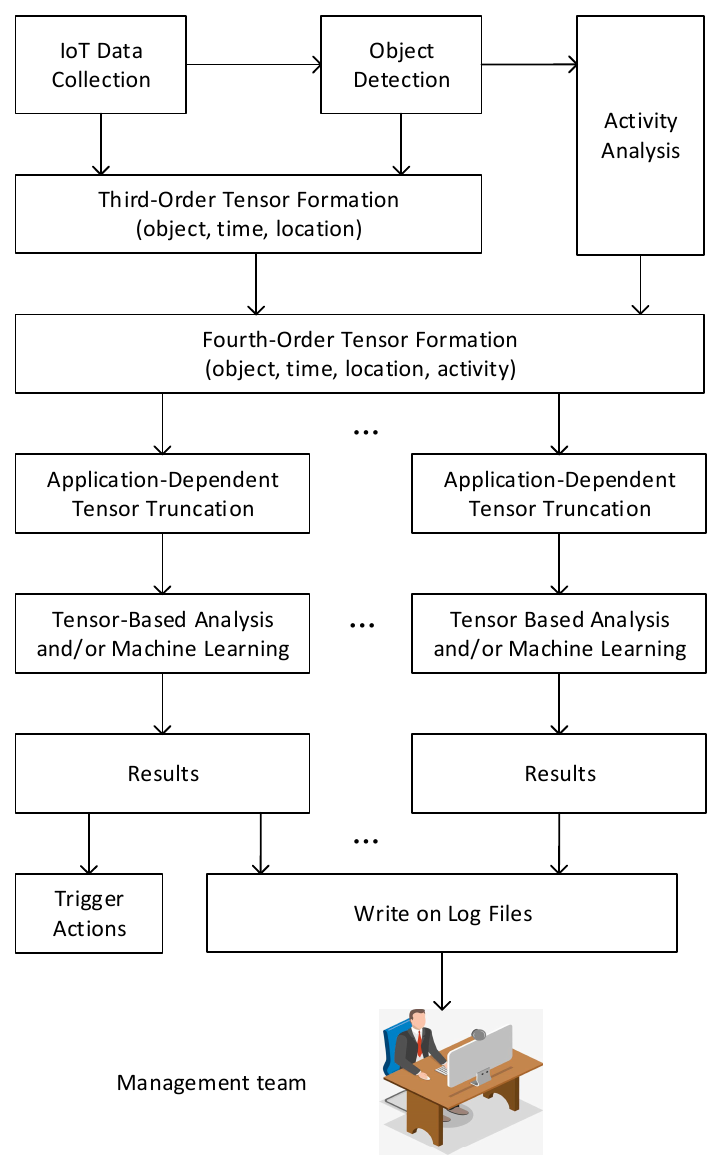
Figure 8. Block diagram of the proposed unified fourth-order tensor-based smart community system.